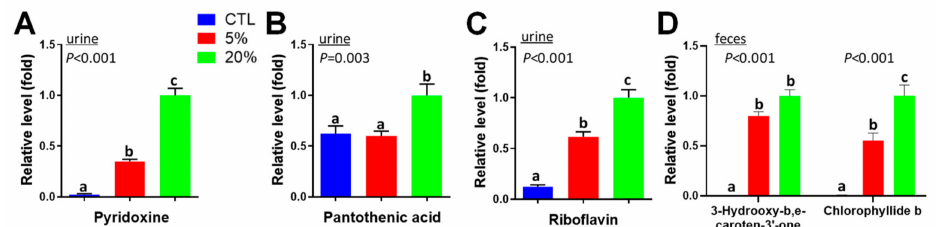
Figure 4. Vitamins and pigments as Scenedesmus exposure markers in urine and feces. ( A ) Pantothenic acid in urine. ( B ) Pyridoxine in urine. ( C ) Riboflavin in urine. ( D ) 3-Hydroxy-b,e-caroten-3 (cid:48) -one and chlorophyllide b in feces. P -values indicate overall significances across all sample groups from the one-way ANOVA test. Means with di ff erent letter labels (a,b,c) indicate significant di ff erences ( P < 0.05) between two dietary treatments by the Tukey post hoc